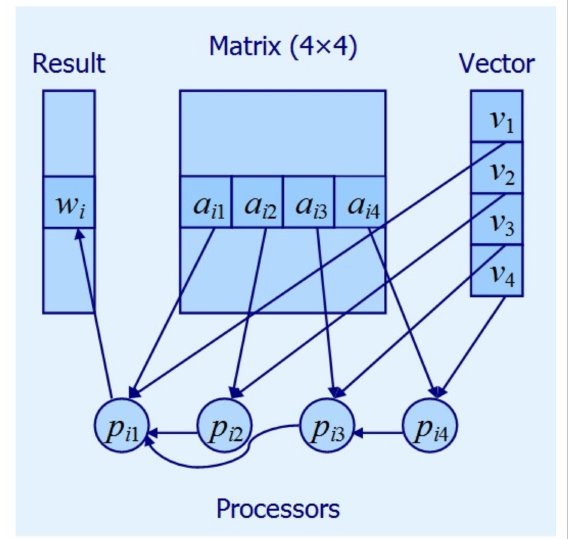
Figure 15. Information graph of the computational process of the i -th row multiplication of the matrix (4 × 4) by the vector (4 ×